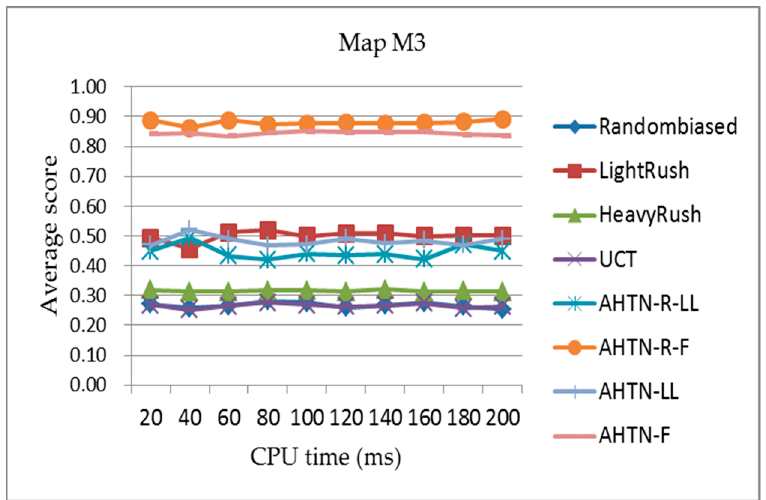
Figure 9. The average score of each algorithm obtained over the 800 games of the round-robin competition for map M3 (16 × 16 tiles) with respect to the CPU time from 20 to 200 ms. The playout time is 100 cycles.